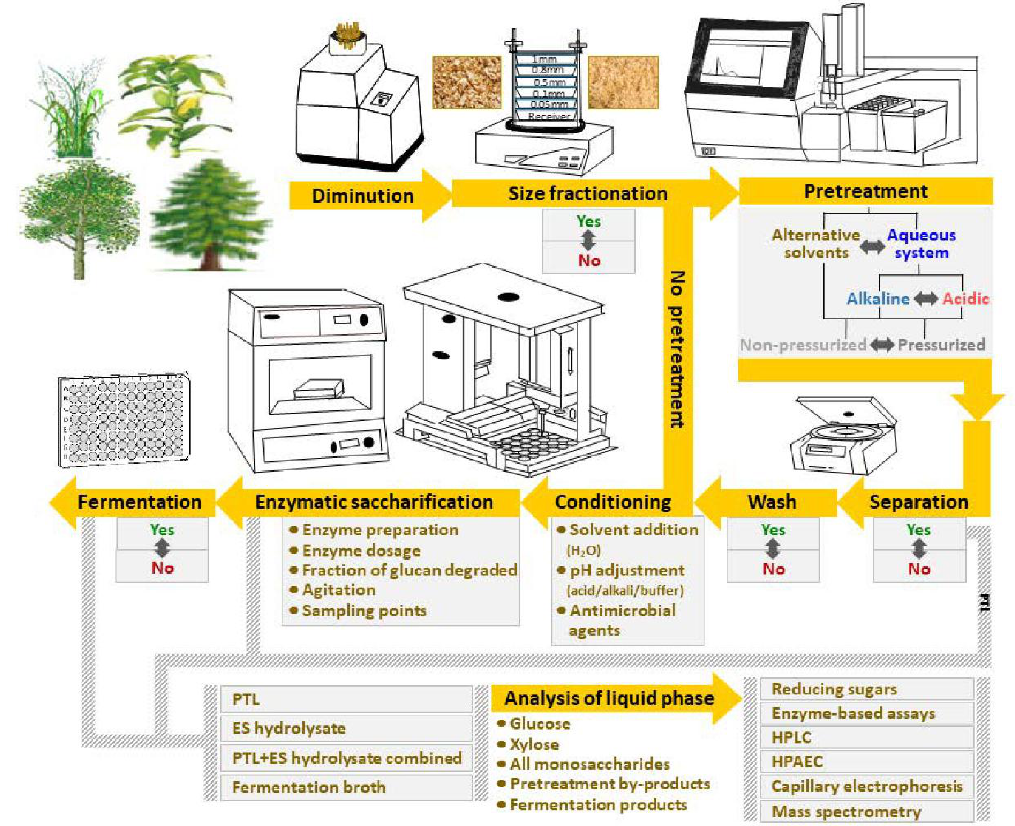
Figure 1. Schematic depiction of typical workflow of analytical enzymatic saccharification of lignocellulosic feedstocks.